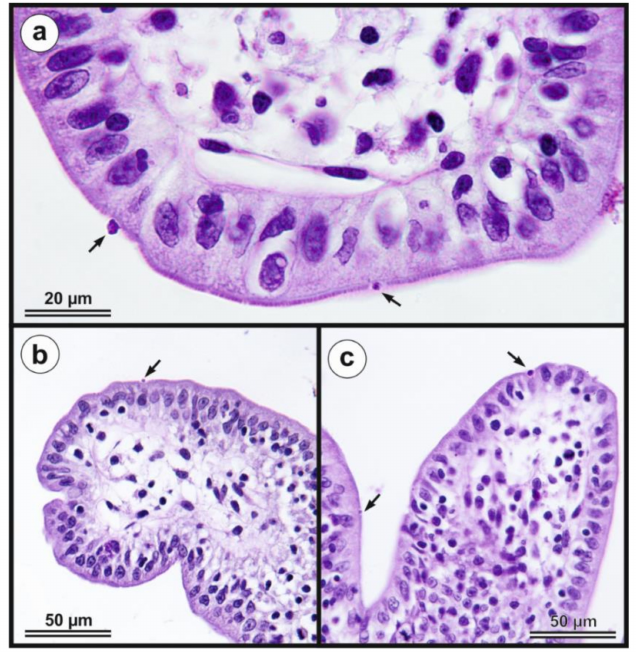
Figure 7. Histological sections stained by periodic acid–Schiff showing developmental stages of Cryptosporidium myocastoris n. sp. (arrow) on ( a ) jejunal and ( b,c ) ileal mucosal epithelium in experimentally infected adult nutria ( Myocastor coypu ) which was sacrificed 10 days post infection. Scale bar is included in each figure.